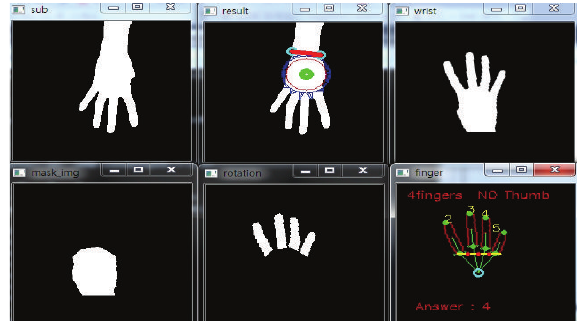
Figure 18: The recognition of the hand gesture S2.